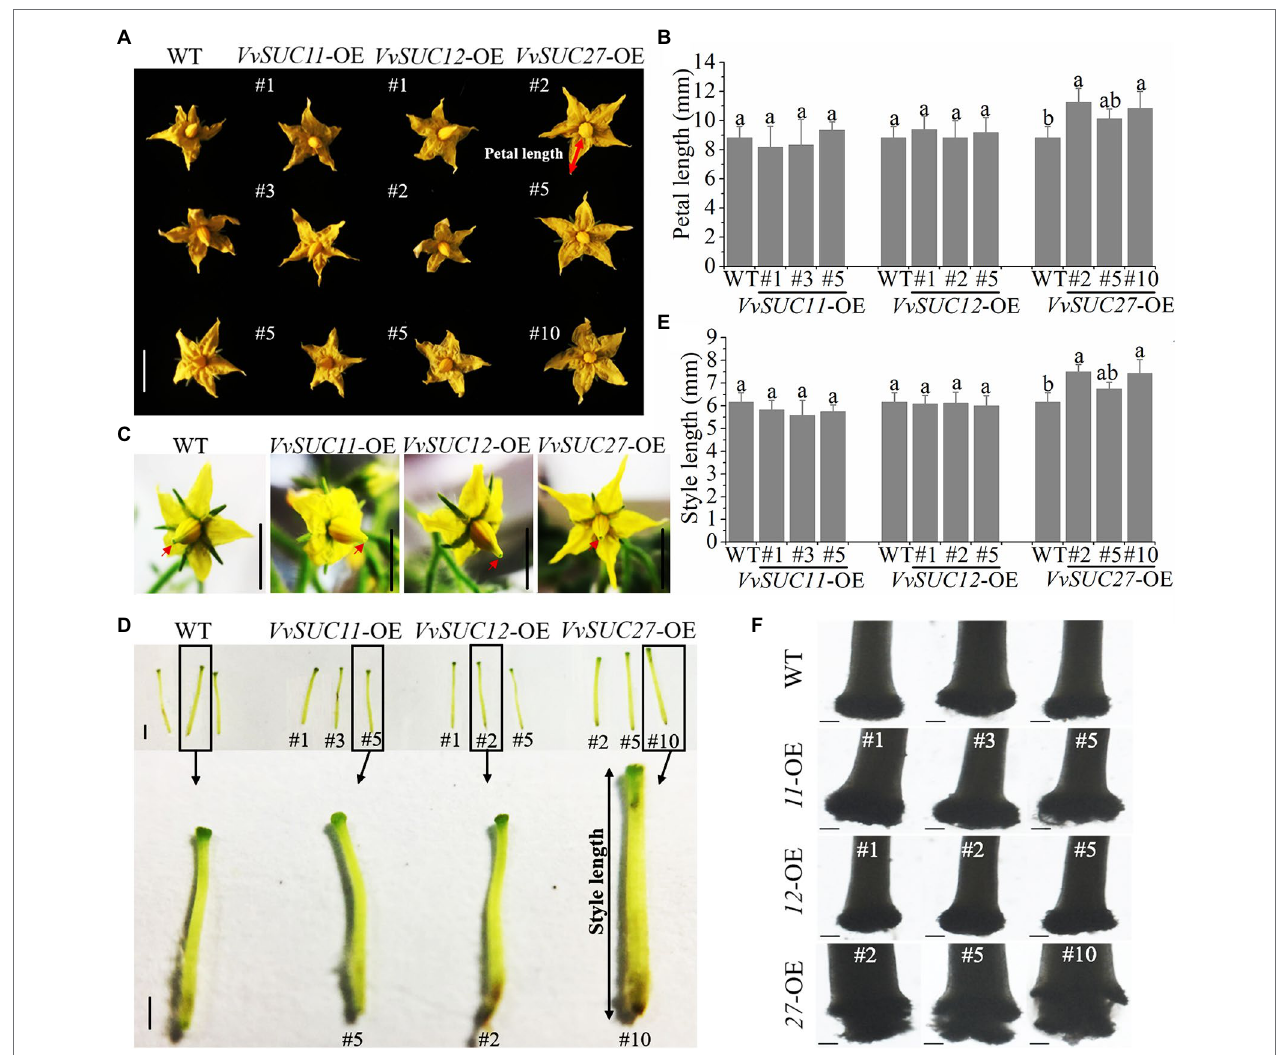
FIGURE 1 | Phenotype of VvSUC -OE tomato flowers. (A) Comparisons between WT and each VvSUC -OE line regarding the phenotype of flowers. Scale bar, 1 cm. (B) Comparisons between WT and each VvSUC- OE line for petal length. Petal length was measured using the red arrow shown in (A) . Error bars indicate mean ± SD of ten biological replicates. Different lowercase letters show statistically significant differences between WT and each VvSUC -OE line (Tukey’s test, p < 0.05). (C) Close observation of the flowers of the WT and each VvSUC -OE line. Scale bar, 1 cm. The stigmas are indicated by red arrows. (D) Comparisons between the WT and each VvSUC -OE line regarding style phenotype. Scale bar, 100 μ m. (E) Comparison between the WT and each VvSUC -OE line regarding the style length. Style length was measured using the black arrow shown in (D) . Error bars indicate mean ± SD of ten biological replicates. Different lowercase letters show statistically significant differences between the WT and each VvSUC -OE line (Tukey’s test, p < 0.05). (F) Observation of the stigma of the WT and VvSUC -OE lines by microscopy. Scale bar, 100 μ